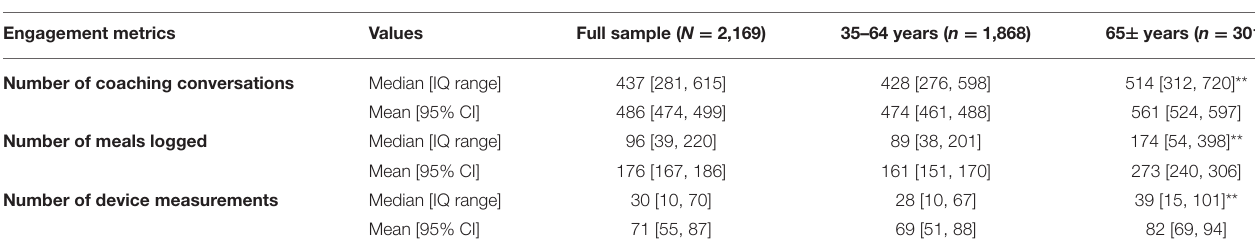
TABLE 2 | Engagement metrics of users across all programs. Engagement